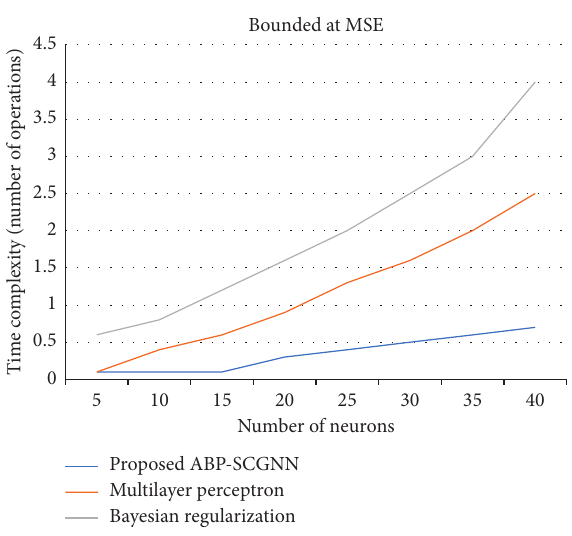
Figure 5: The time complexity of the ABP-SCGNN model at different neurons of hidden layer.